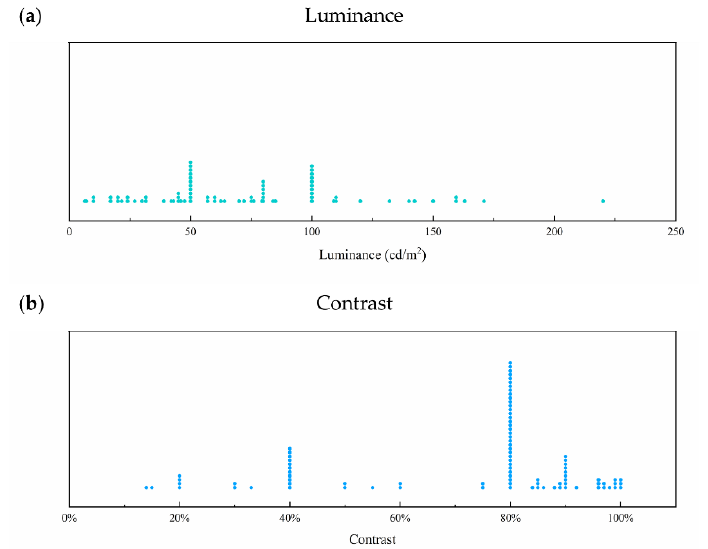
Figure 2. ( a ) Luminance and ( b ) contrast of visual stimulus in selected studies. Each point represents one luminance or contrast value used in one of the studies.